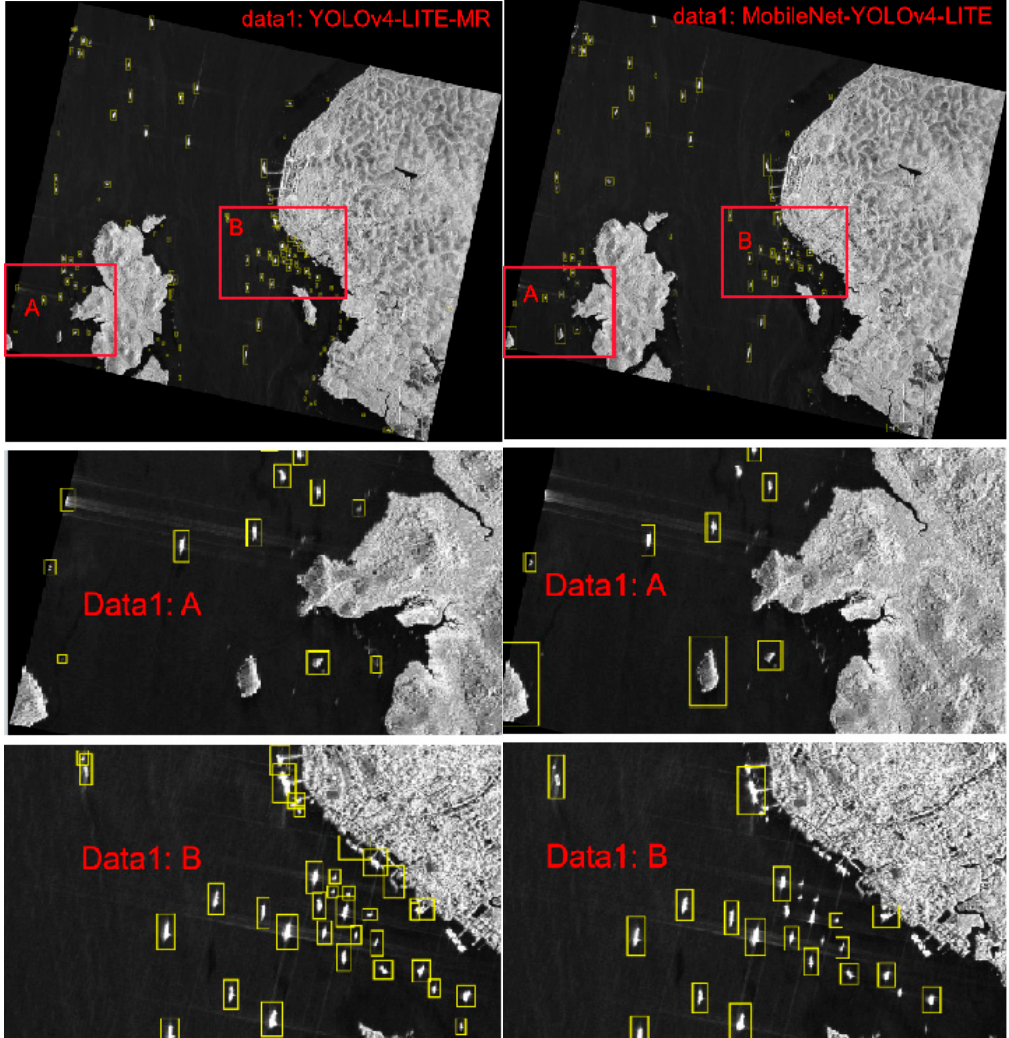
Figure 12. Comparison of the detection results of YOLOv4-LITE-MR (left column) and MobileNet-YOLOv4-LITE (right column) in data1. A and B are sub-images in data1.